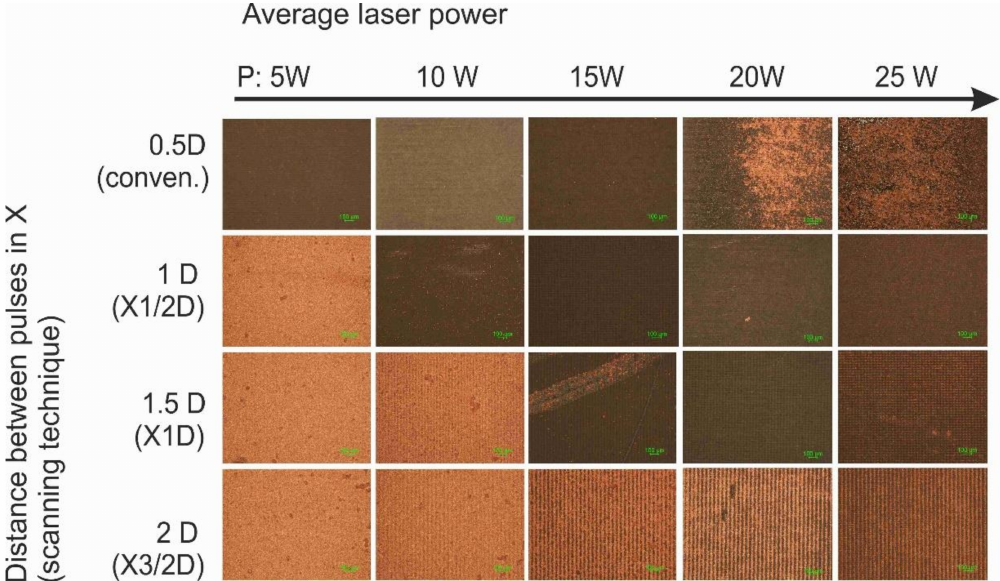
Figure 5. Optical microscope images of surface deposited with copper after electroless plating. Different average laser powers (5, 10, 15, 20 and 25 W (in columns)) and different types of scanning (conventional, X1/2D, X1D and X3/2D) were applied for comparison of laser excitation. The scale bar of all images corresponds to 100 µm.